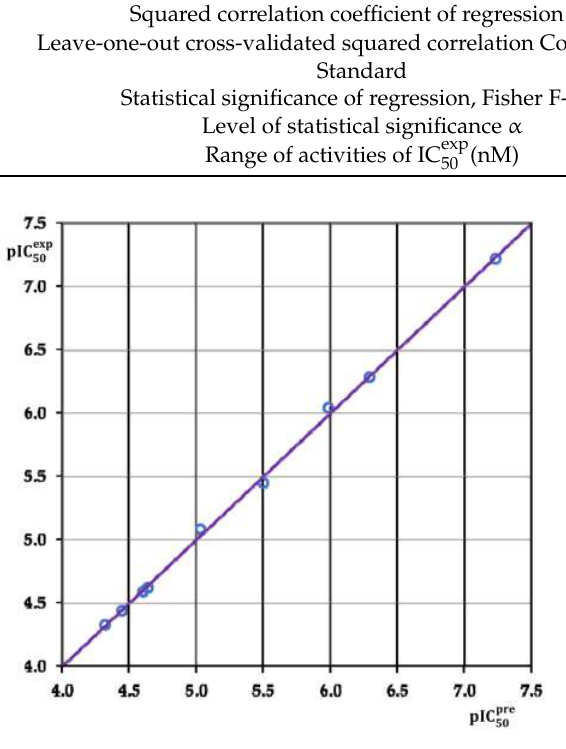
Figure 6. Plot of estimated and experimental activity for PH4 Hypo